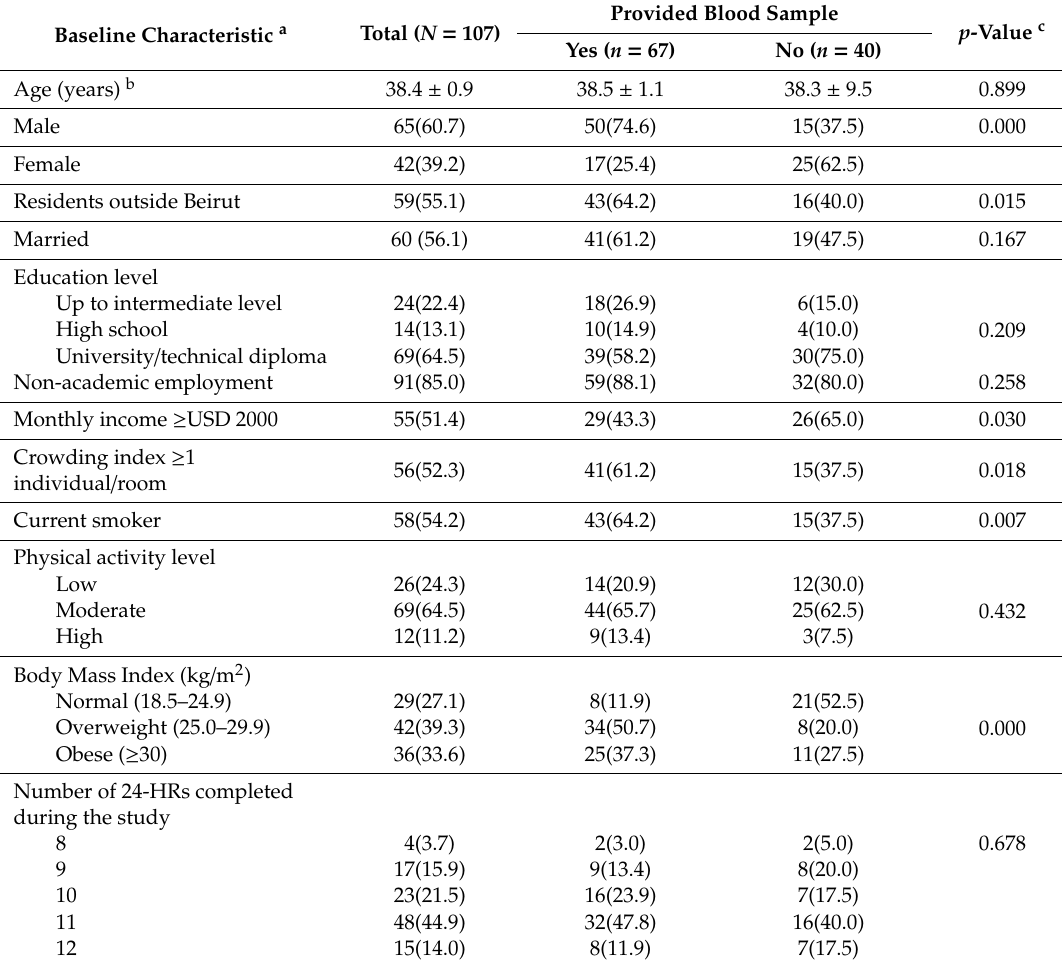
Table 1. Baseline characteristics for study participants and for those who did (Yes) or did not (No) provide a blood